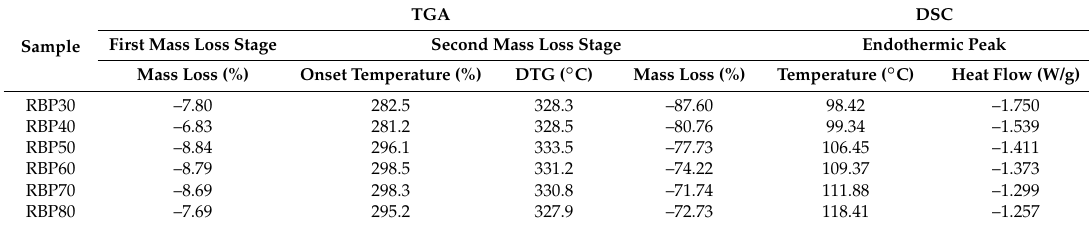
Table 3 Thermal properties of RBPs. Table 3. Thermal properties of RBPs.